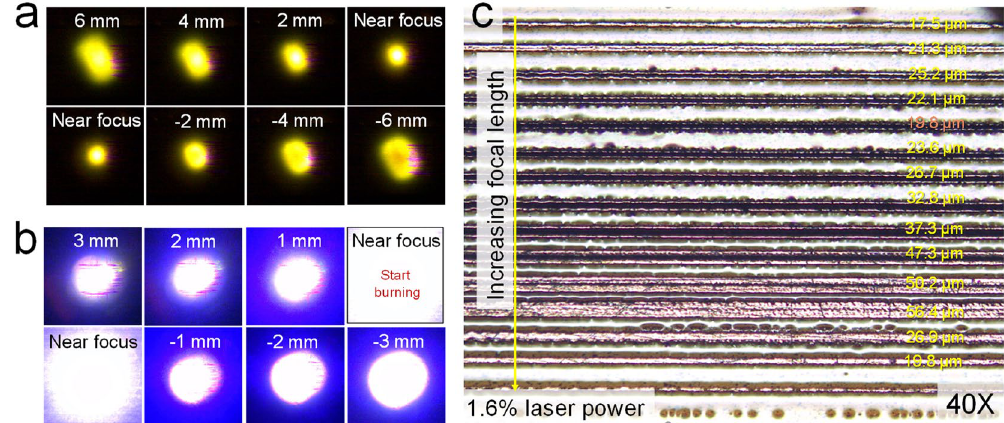
Figure 2. Focusing the laser beam: ( a ) Finding the laser focal length using a USB camera, ( b ) determining the focal length using a burning point on bare PI film at 1.6% pulse width modulation (PWM) input signal, and ( c ) determining the focal length through Cu patterns formed at various focal lengths using a G-code program (scan speed of 1 mm/s and 2% PWM).